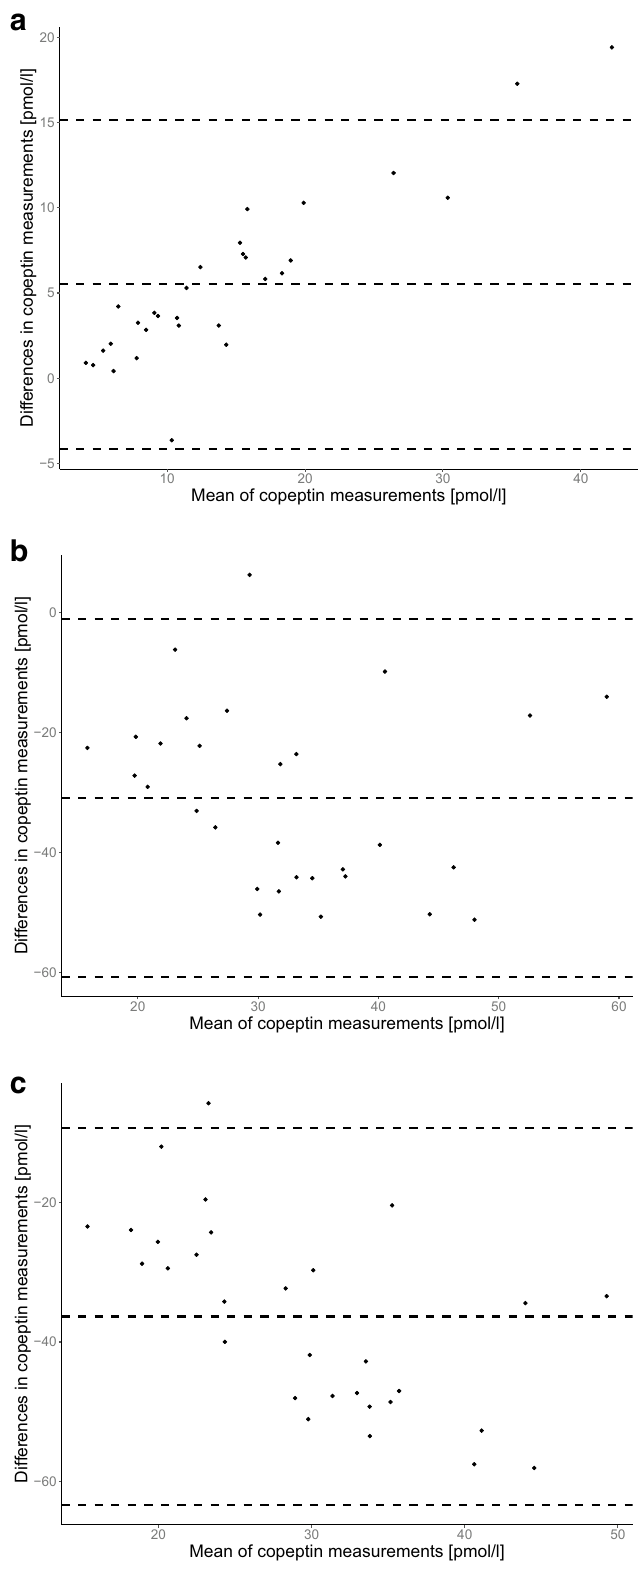
Figure 2. Inter-assay difference in copeptin concentrations in healthy volunteers. Bland–Altman graph of inter-assay difference in copeptin concentrations in healthy volunteers for ( a ) the KRYPTOR vs LIA, ( b ) the KRYPTOR vs ELISA and ( c ) the LIA vs ELISA. The dotted middle line represents the mean difference in copeptin concentrations between the two different assays (( a ): 5.51 pmol/l (95% limits − 4.16 to 15.18), ( b ): − 30.8 pmol/l (95% limits − 60.63 to − 1.03), ( c ): − 36.34 pmol/l (95% limits − 63.37 to − 9.32)). The outer dotted lines represent the 95% confident interval limits of agreement. ( a ) KRYPTOR vs LIA, ( b ) KRYPTOR vs ELISA, ( c ) LIA vs